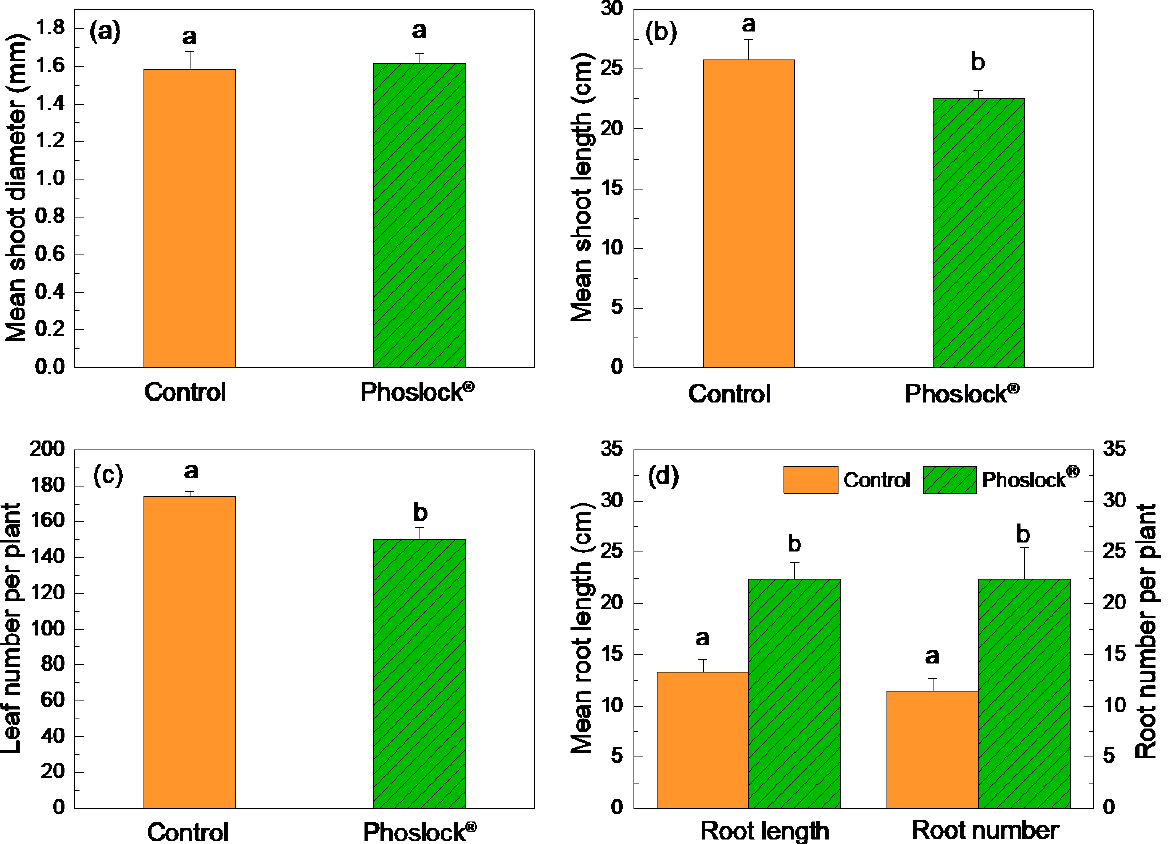
Figure 3. Morphological parameters of Myriolhyllum spicatum included mean shoot diameter ( a ), mean shoot length ( b ), leaf number per plant ( c ) and root parameters ( d ) in both the control (without Phoslock ® addition) and Phoslock ® (with Phoslock ® addition) treatments at the end of experiment. Different letters indicate a significant difference between the two treatments at p < 0.05. Error bars represent the standard deviations (SD).